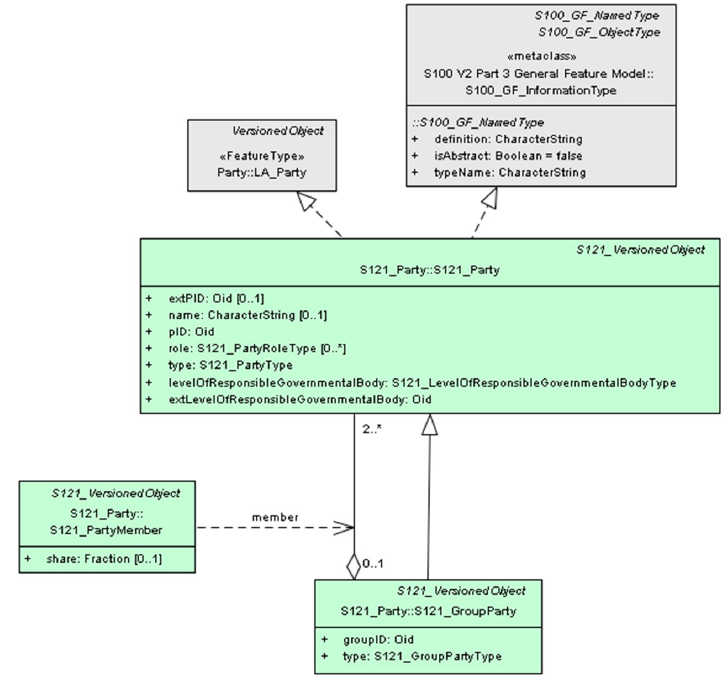
Figure 5. S-121 Party package ([18], p. 57, edited by the authors).